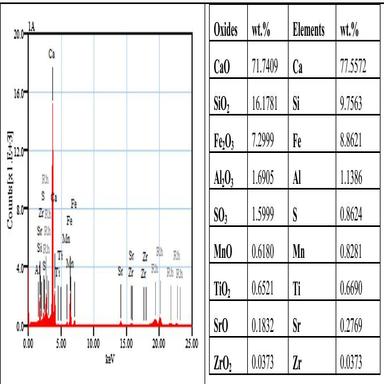
XRF analysis of solidified cement mixed with slag and titanate nanofibers.